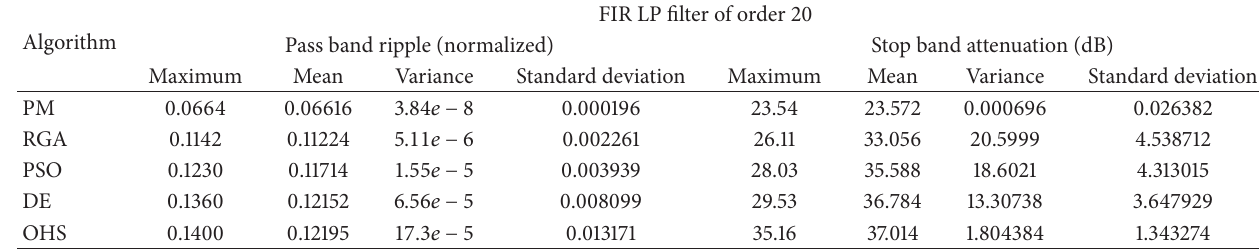
Table 11: Statistical parameters of FIR LP filters for different algorithms.